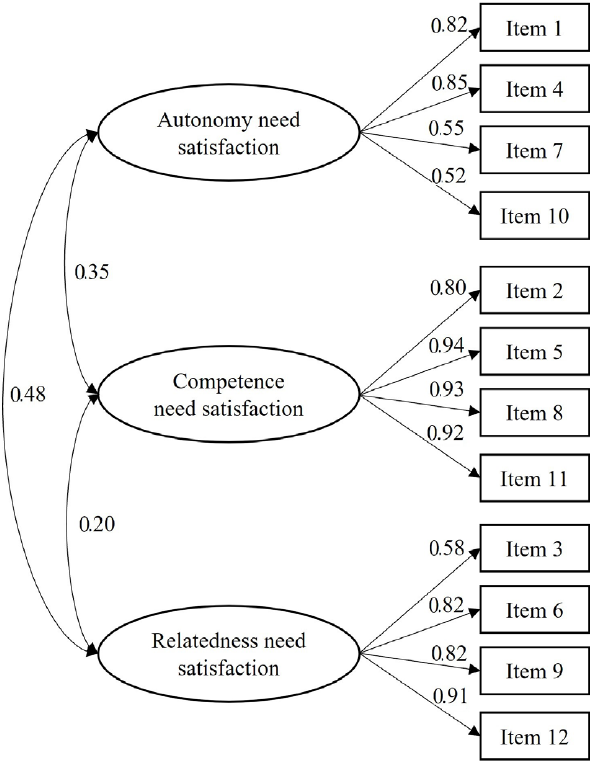
Figure 1. Confirmatory factor analysis. Table 1. Means and standard deviations, factor loadings; construct reliability; average variance extracted; and correlations among